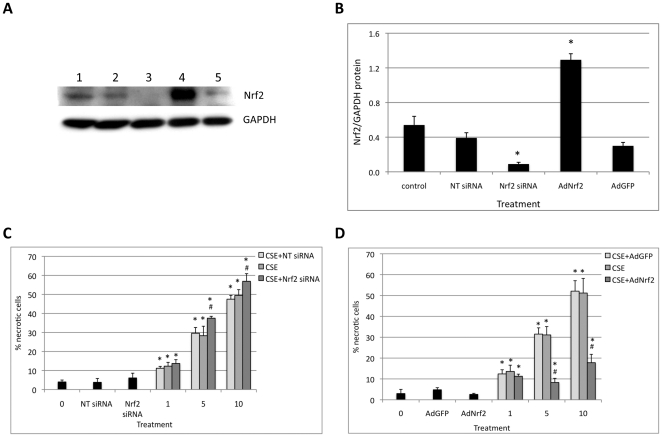
Effect of Nrf2 knockdown and overexpression in ATI-like cells exposed to CSE.A – Nrf2 expression (immunoblotting); Lane 1 – control; lane 2–300 nM NT siRNA; lane 3–300 nM Nrf2 siRNA; lane 4–200 MOI AdNrf2; lane 5–200 MOI AdGFP (see Materials and Methods); B - Quantitation of Nrf2 relative protein expression in ATI-like for experiments shown in A. * - Statistically significant increase in protein expression induced in comparison with negative control (p<0.05); C – Nrf2 knockdown sensitizes cells to CSE. Cells were transfected with Nrf2 siRNA for 24 h followed by exposure to CSE for 24 h and toxicity was measured by propidium iodide and Hoechst 33342 double staining. D - Nrf2 overexpression protects cells exposed to CSE. Cells were infected with AdNrf2 for 24 h, exposed to CSE for 24 h and necrotic cells were detected by Hoechst 33342 and propidium iodide double staining. * - Statistically significant increase in percentage of necrotic cells induced by CSE in comparison with control. # - Statistically significant increase for C or decrease in D in ATI-like necrotic cells after transfection with Nrf2 siRNA or infection with AdNrf2, respectively followed by CSE in comparison with CSE alone. Data represent results from three independent experiments (p<0.05).